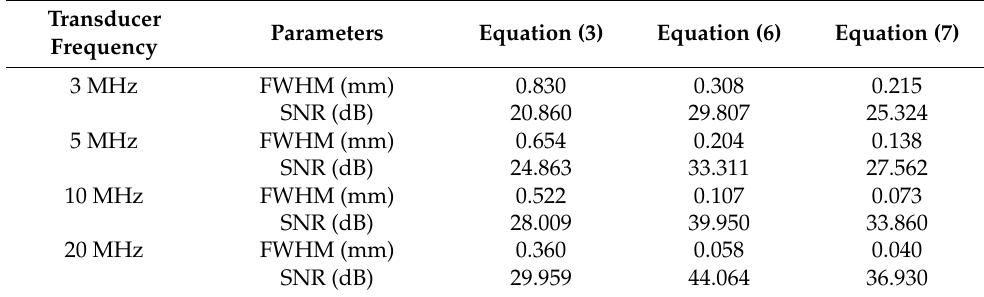
Figure 5. Simulation results with different reconstruction methods when the transducer central frequency varies. ( a – d ) The results with the conventional BP method when the central frequencies are 3 MHz, 5 MHz, 10 MHz and 20 MHz, respectively. ( e – h ) The corresponding results with the TDC-BP method. ( i – l ) The corresponding results with the SIR-BP method. The diameter of the employed planar transducer was 5 mm, and the locations of the four points are 0 mm, 1.5 mm, 3 mm, and 4.5 mm, respectively. The simulated data were added with 5 % noise. The amplitudes of all the images are normalized to 1 for comparison. Table 2. The calculated FWHMs and SNRs for the off-center target at 4.5mm reconstructed with different methods and different transducer